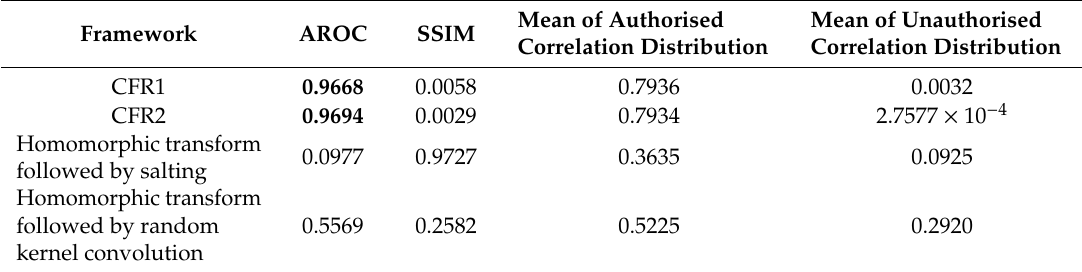
Table 3. Evaluation of CFR frameworks based on LFW dataset (where bold entries indicate best AROC results recorded).